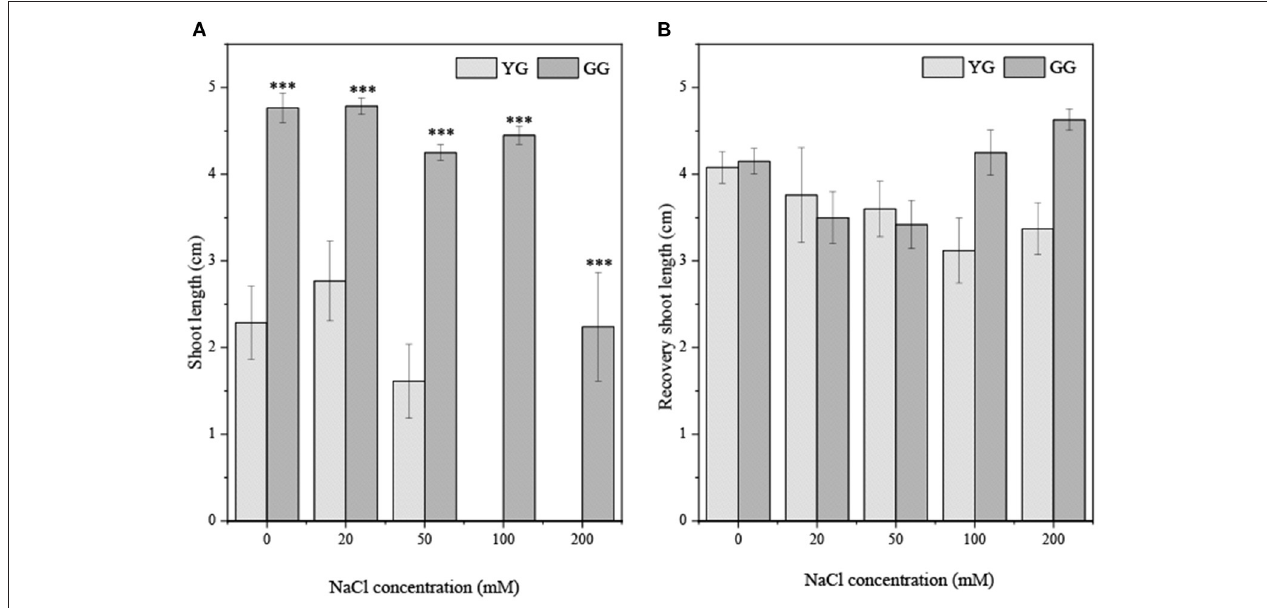
FIGURE 6 | Effects of salt stress on shoot length of seedlings grown from different L. chinensis ecotypes (A) the initially germination (B) the recovery germination; There were twenty replicates for each treatment. Values are presented as means ± standard error (SE). * , ** , *** Indicate significant differences between the different ecotypes under the same NaCl concentration at 0.05, 0.01, and 0.001 level respectively, and “ns” indicates no significant differences.